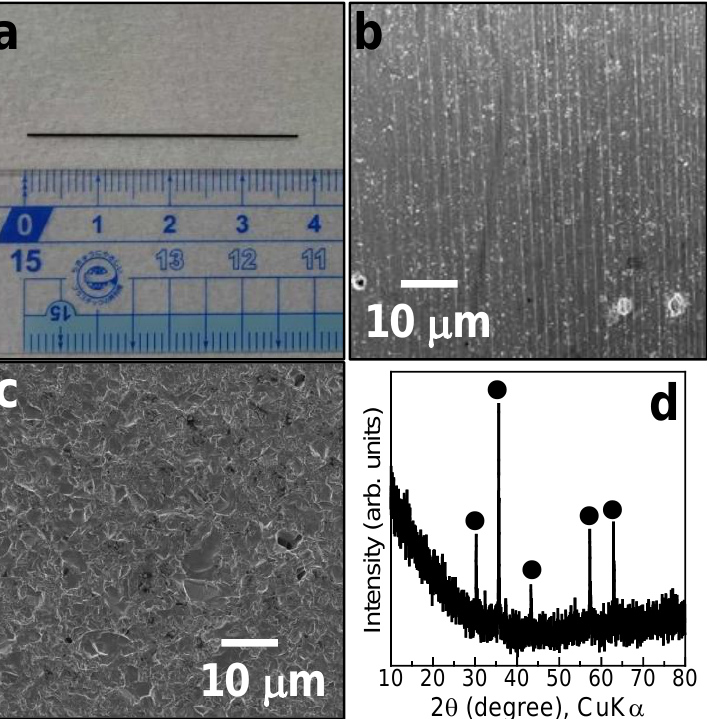
Figure 1. Information on the substrate used in the present work: ( a ) Photograph of the substrate; ( b ): SEM image of the substrate surface obtained by dicing; ( c ) SEM image of the substrate surface obtained by slicing; and ( d ) XRD pattern of the substrate ( ● : Fe 3 O 4 ).